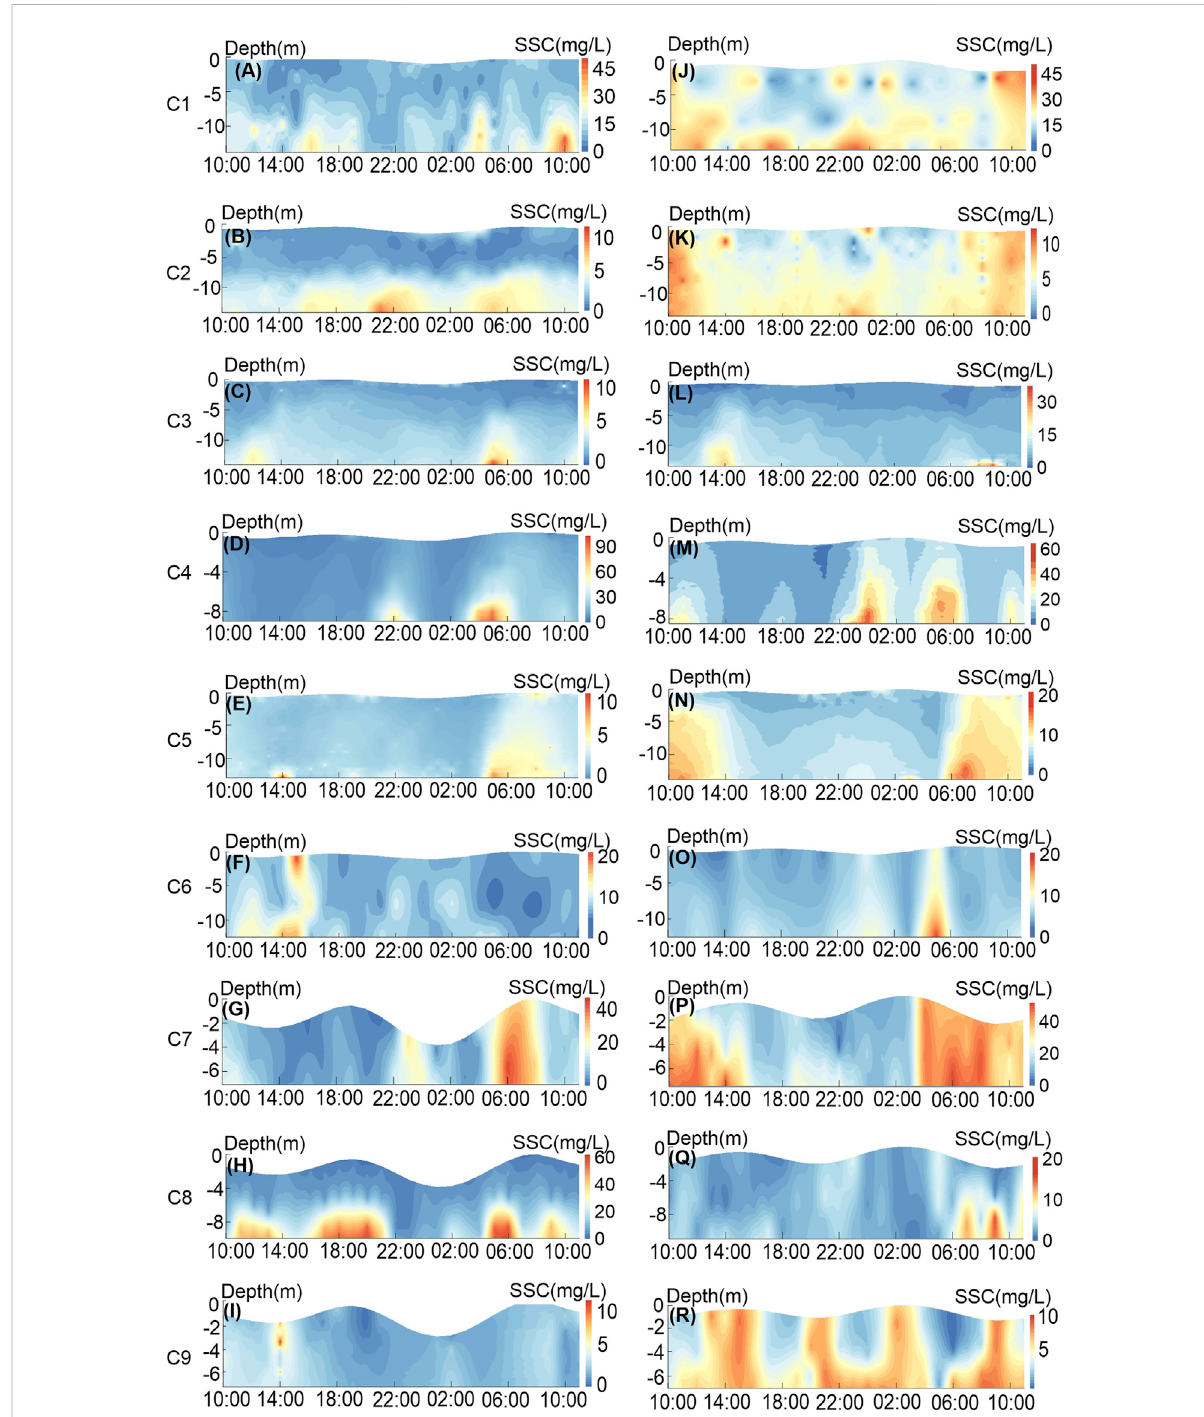
FIGURE 4 Time series of SSC pro fi les at various stations during the spring (A – I) and moderate (J – R)